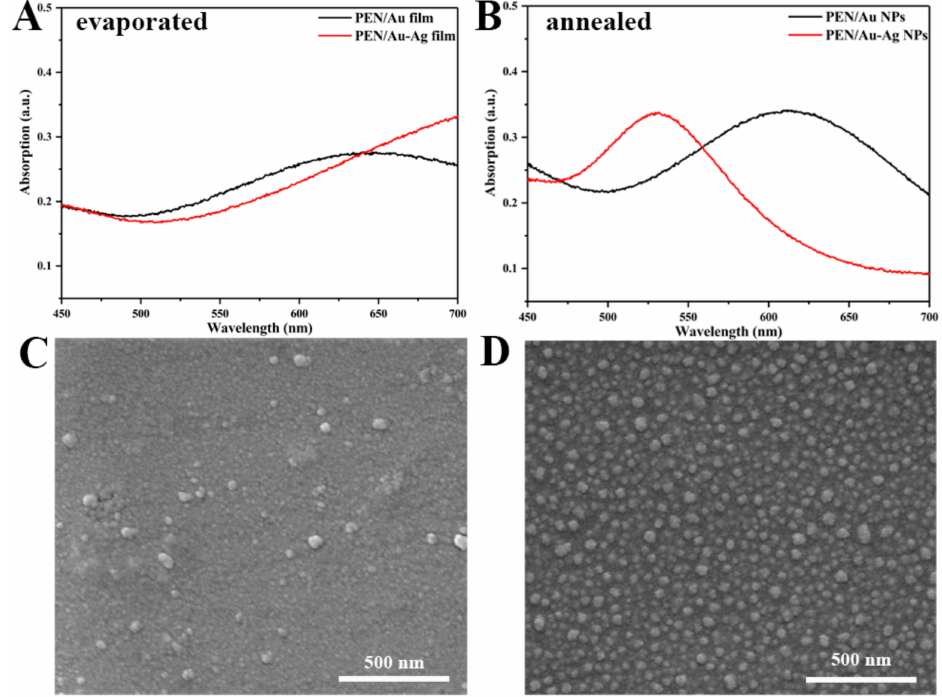
Figure 1. The localized surface plasmon resonance (LSPR) spectra of single metallic PEN / Au and bimetallic PEN / Au-Ag samples before ( A ) and after thermal annealing ( B ). Their corresponding SEM images show the surface morphology of Au NPs ( C ) and Au-Ag NPs ( D ) after annealing. Both samples were annealed at 290 ◦